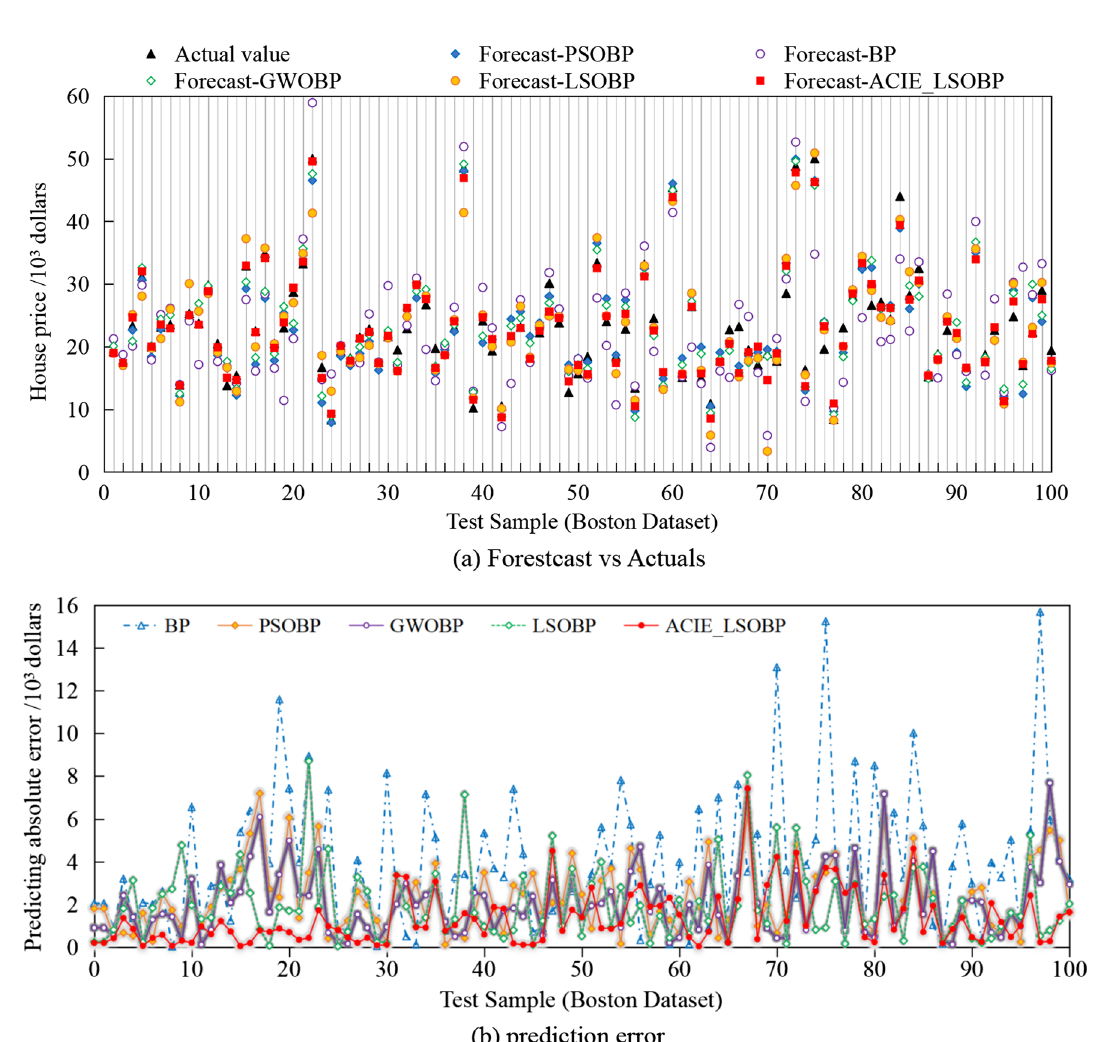
Fig. 5 Comparison of the prediction results of each algorithm on the Boston test